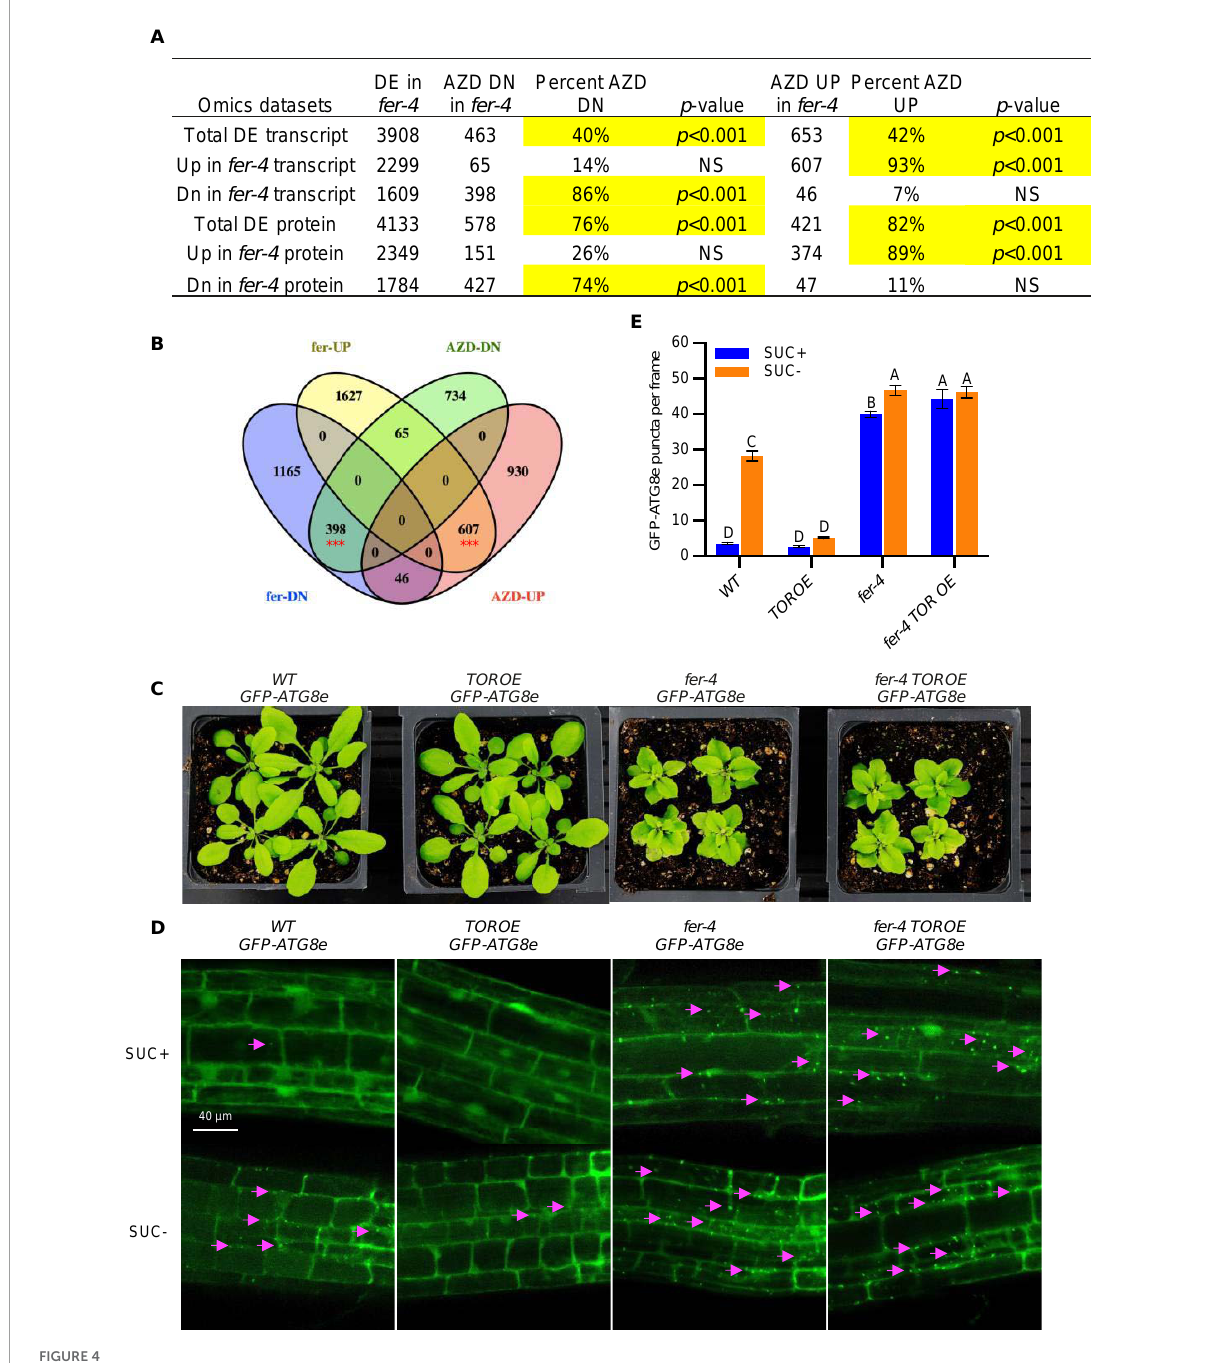
FIGURE4 FER and TOR cooperate in plant growth and autophagy. (A) Hypergeometric tests on the comparisons of AZD-regulated transcripts and differentially expressed transcripts or proteins in fer-4 mutant. Significant overlaps are highlighted in yellow. DE: differentially expressed; NS: not significant. (B) Venn diagram showing the comparison of differentially expressed transcripts in fer-4 and differentially expressed genes in response to TOR kinase inhibitor AZD8055 treatment (Dong et al., 2015). The red *** represents the overlaps statistically significant with p < 0.001. (C) Growth phenotype of 3-week-old plants of WT, fer-4 , TOROE and fer-4 TOROE double mutant. (D) Representative confocal microscopic images of WT, fer-4 , TOROE and fer-4 TOROE with autophagosome marker GFP-ATG8e, under control (SUC +) and sucrose starvation (SUC-) conditions. The Lavender arrows indicate the autophagosomes. Scale = 40 µ m. (E) Quantification of autophagosomes in different genotypes expressing GFP-ATG8e from 10-day-old seedlings with or without sucrose for 3 days. Data are shown as means ± SEM from 3 biological replicates, with 14-31 images per replicate. Different letters indicate significant difference among groups subjected to one-way ANOVA Tukey’s multiple range tests ( p <